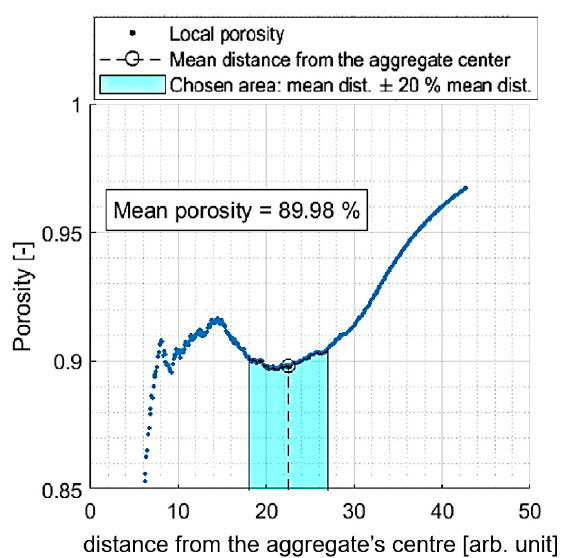
Figure 22. Scheme of porosity designation. Exemplary plot presenting local porosity dependence on distance from the aggregate’s centre and the chosen representative area.